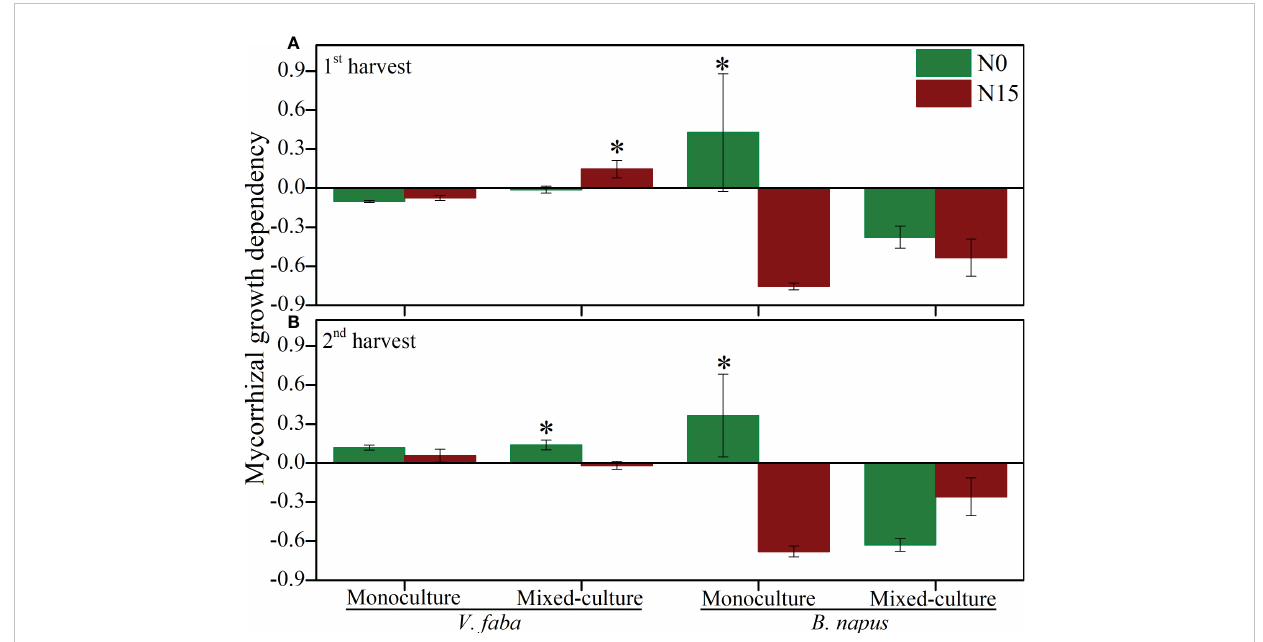
FIGURE 4 Mycorrhizal growth dependency (MGD) of V. faba and B. napus under N-addition conditions of N-0 and N-15. (A) shows 1st harvest, (B) shows 2nd harvest. * denotes signi fi cant